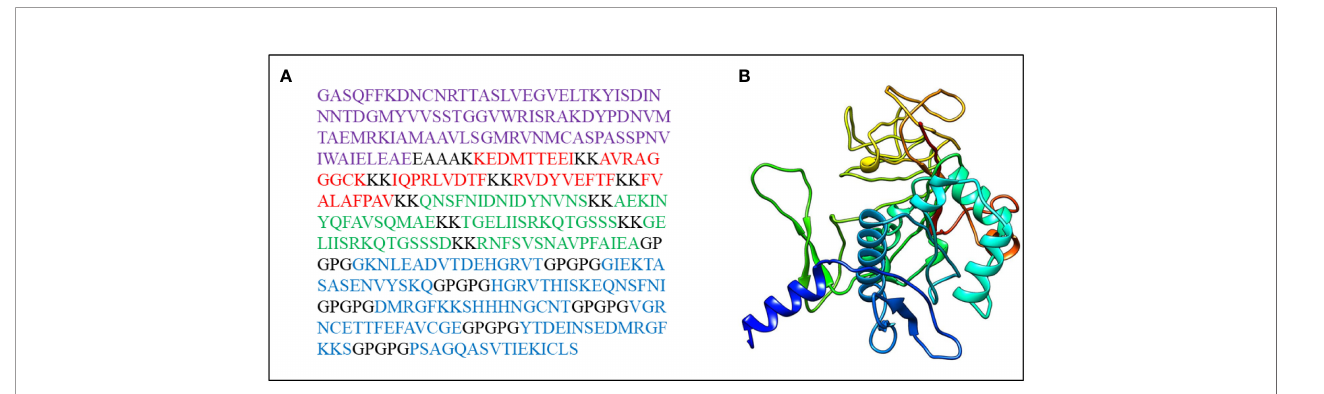
FIGURE 1 | Flowchart of the multi-epitope vaccine